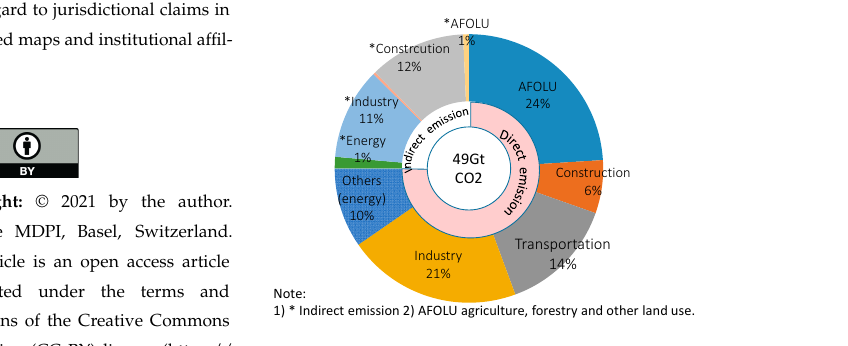
Figure 1. Global CO 2 emissions